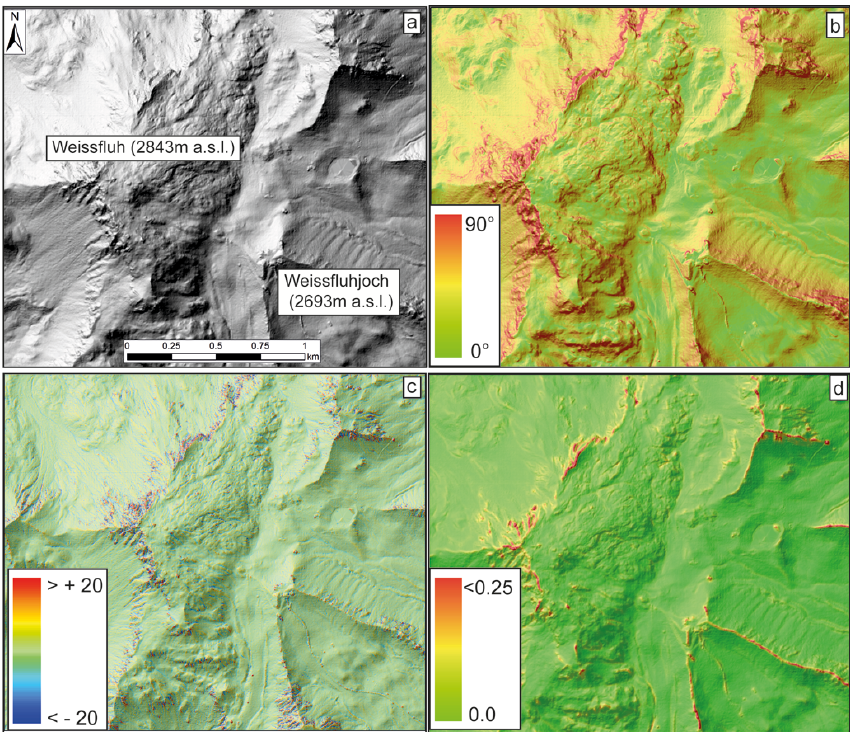
Fig. 4. (a) Hillshade and the (b) governing parameters slope, (c) plan curvature and (d) ruggedness with a neighborhood of 11 pixels considered calculated from the original DSM with a spatial resolution of 2m covering the Weissfluhjoch area in Davos, Switzerland.